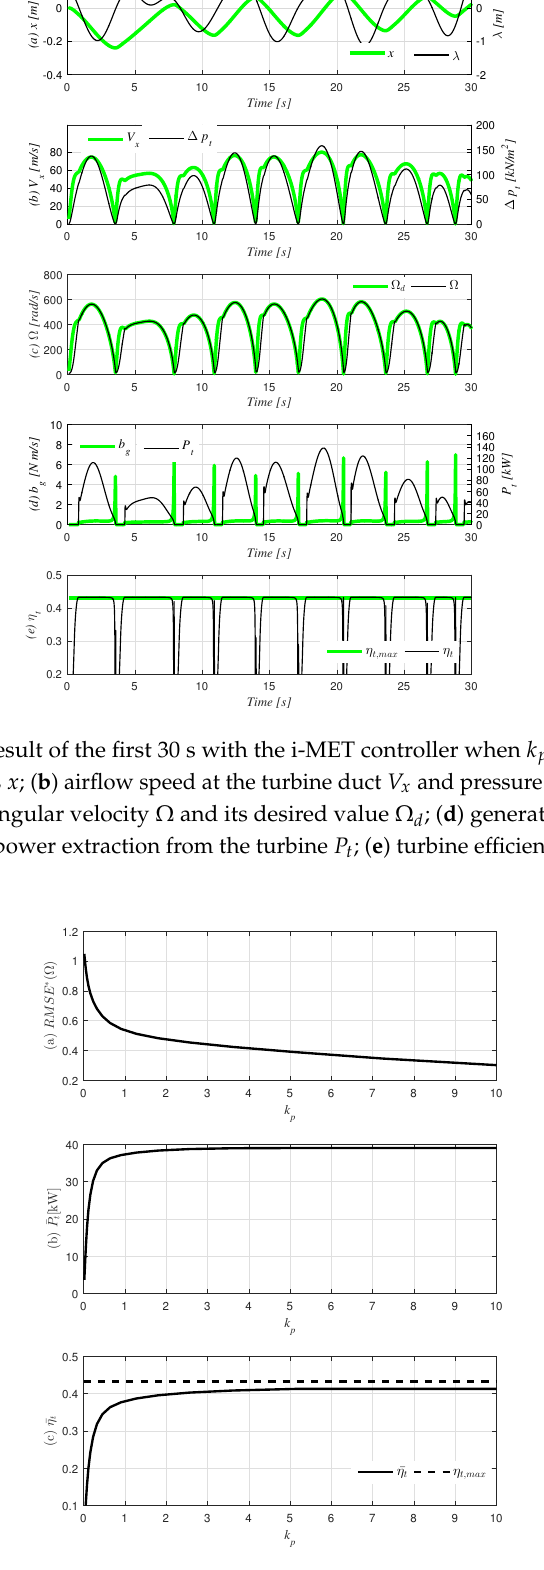
Figure 6. Results of the i-MET controller with various k p under equivalent irregular wave conditions: ( a ) relative root mean squared error of Ω ; ( b ) average power extraction from the turbine; ( c ) average turbine efficiency and its maximum